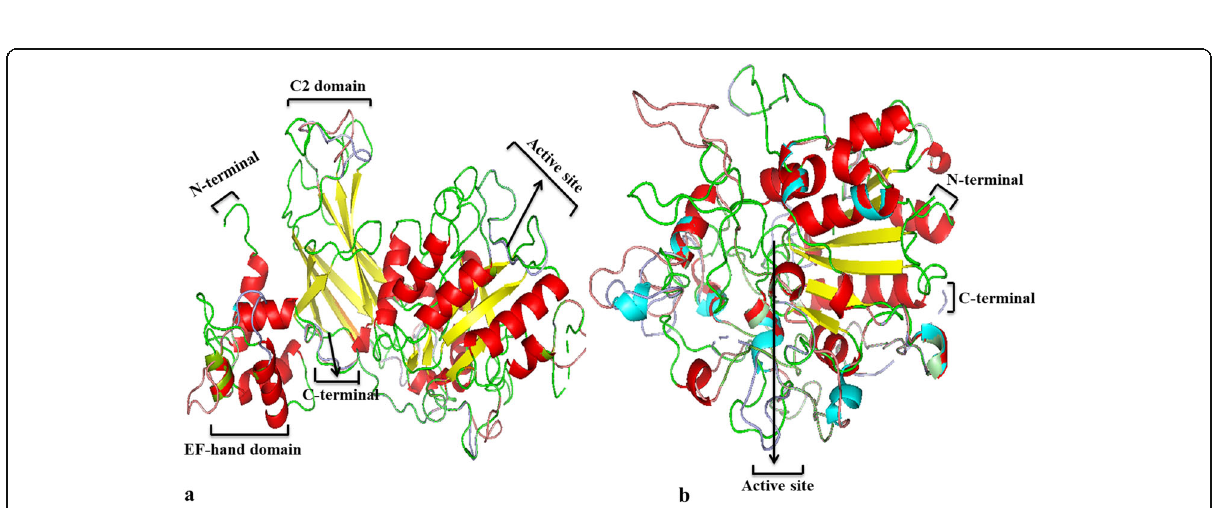
Fig. 8 Simulated three-dimensional super-imposed structures. a Superimposed structure of PePI-PLC6A, DcPI-PLC6A and AsPI-PLC6. b Superimposed structure of PePC-PLC1, DcPC-PLC1A and